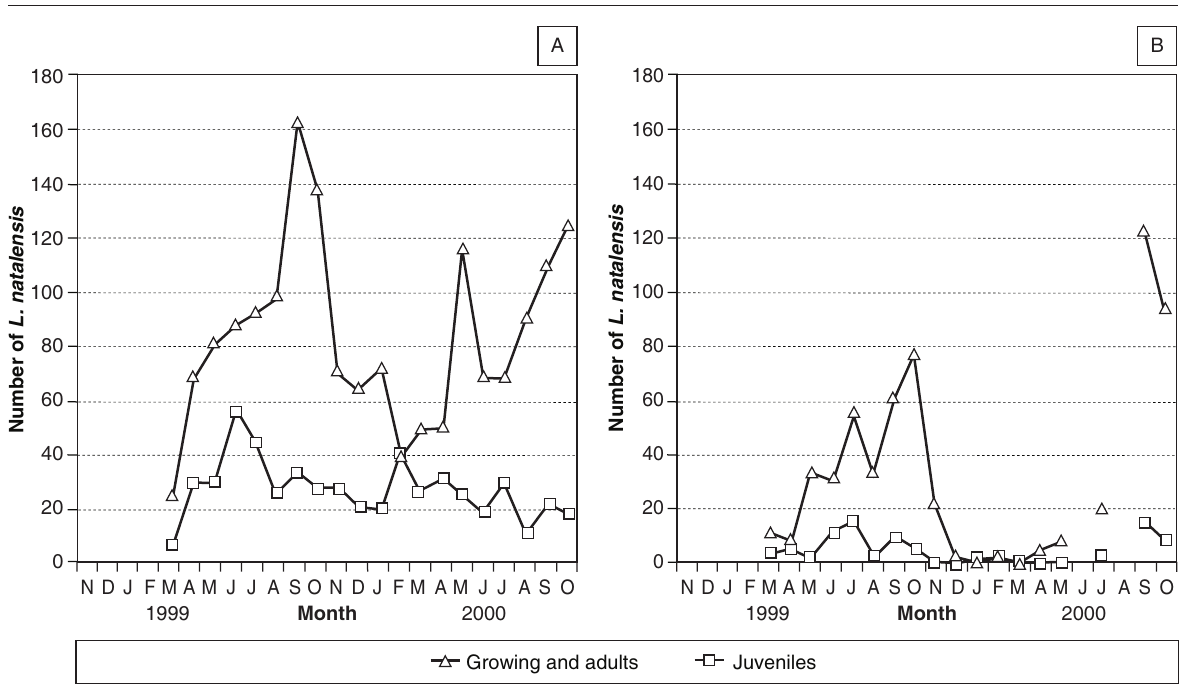
FIG. 4 Monthly variations of juvenile (4–5 mm shell height) and growing/adult (> 5 mm) Lymnaea natalensis snails in the highveld (A) and lowveld (B) communal grazing areas of Zimbabwe sampled for the period November 1998 to October 2000